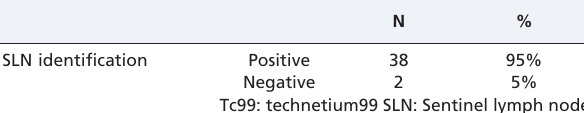
Table 4 - Comparison of the intersection of the methods discussed in this research to identify the SLN in the axilla (right and left